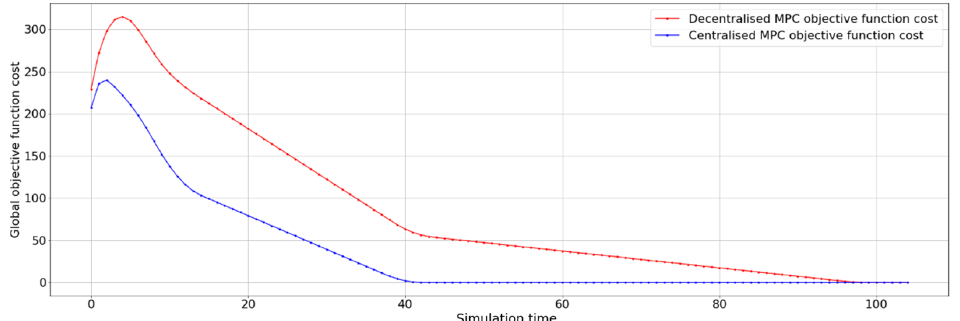
Figure 12. Solution for y-variables of the decentralised MPC. Figure 13. Sum of local objective function costs of the decentralised MPC and objective function cost of the centralised MPC.